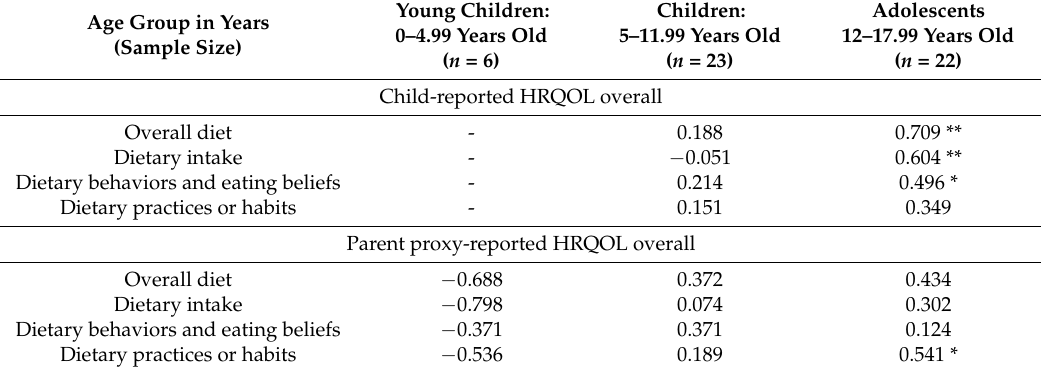
Dietary behaviors and eating